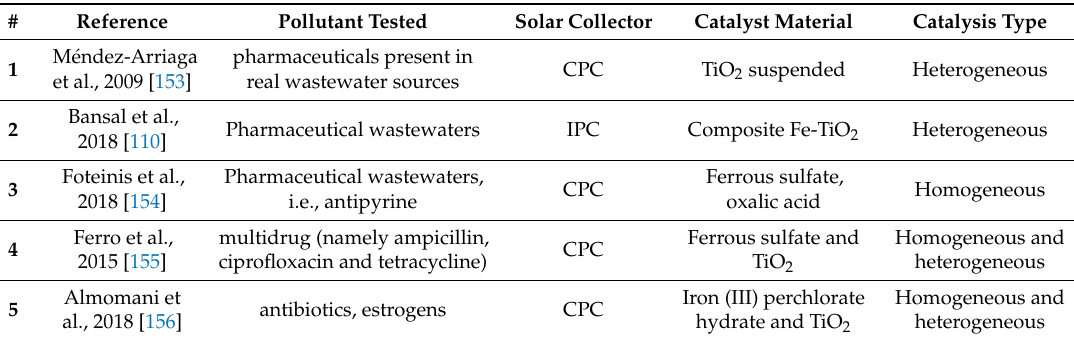
Table 11. BROCs real wastewaters (Pharmaceuticals).